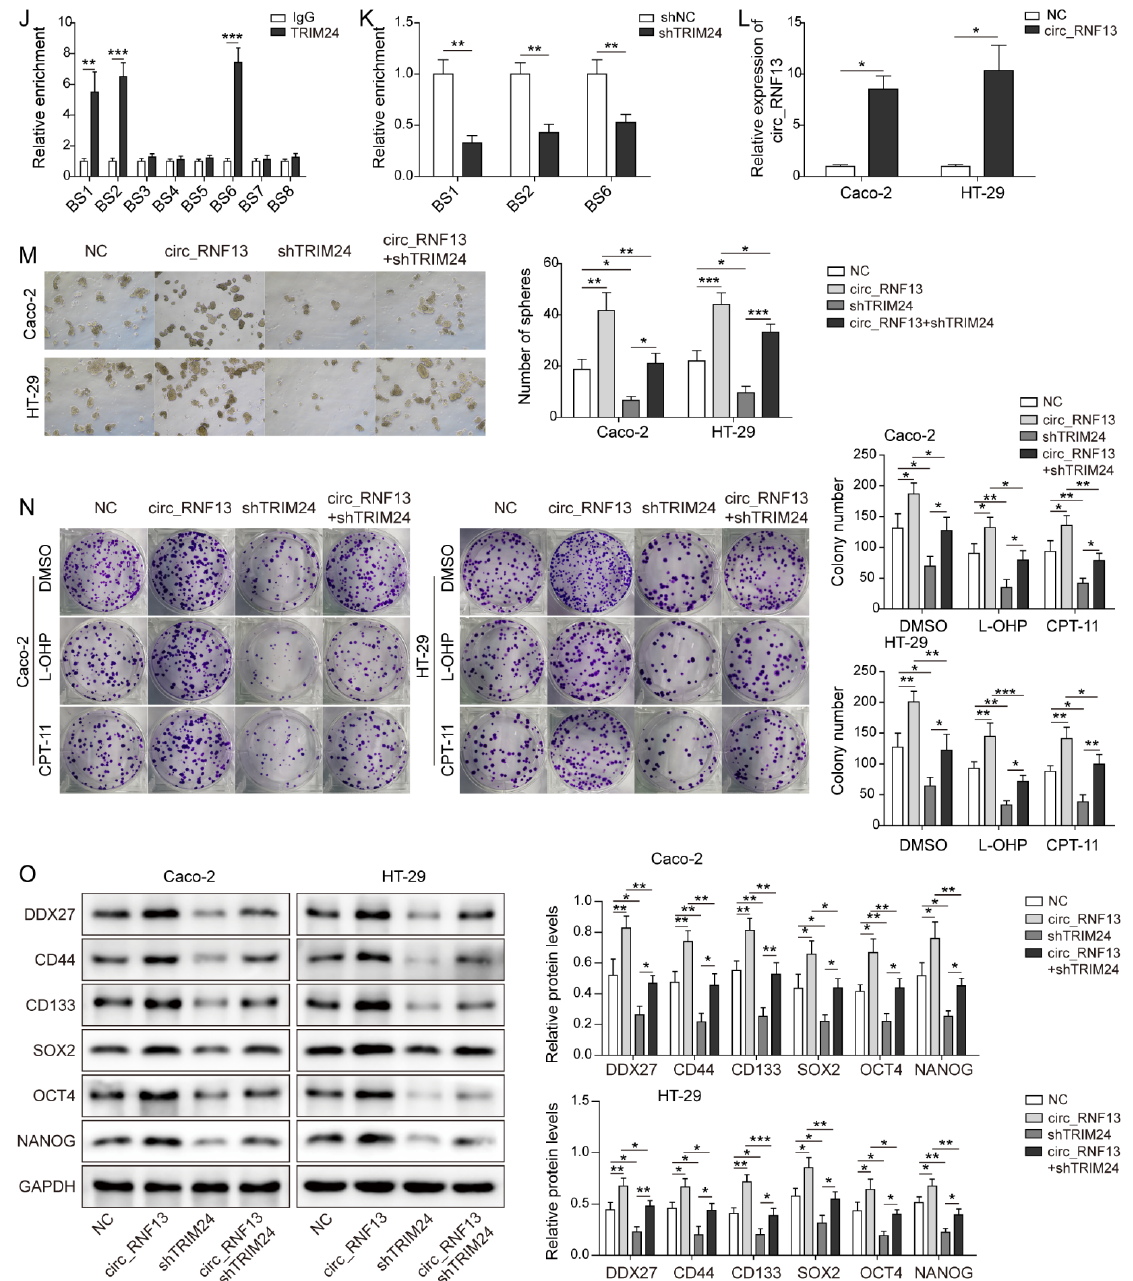
Figure 5. Circ_RNF13 regulates DDX27 expression via TRIM24-mediated transcriptional regulation. ( A ) The association between circ_RNF13 and TRIM24 was determined by RNA pull-down assay. Scrambled RNA served as a negative control. ( B ) The interaction between circ_RNF13 and TRIM24 was detected by RIP assay. ( C ) The subcellular localizations of TRIM24 and circ_RNF13 were detected by FISH/IF staining. Red, circ_RNF13; green, TRIM24; blue, DAPI. Scale bar, 25 μ m. ( D ) Analysis of TRIM24 expression in CRC tumor samples based on the TCGA database. ( E ) The correlation between TRIM24 and DDX27 in CRC tumor samples based on the TCGA database. ( F ) The protein level of TRIM24 was detected by Western blot analysis in CRC tumor samples. ( G ) The correlation between TRIM24 and DDX27 in CRC tumor samples. ( H ) The protein levels of DDX27 and TRIM24 were detected by Western blot analysis in CRC cells. ( I ) Putative binding sites of TRIM24 on DDX27 promoter. ( J , K ) The interaction between TRIM24 and the DDX27 promoter was detected by ChIP